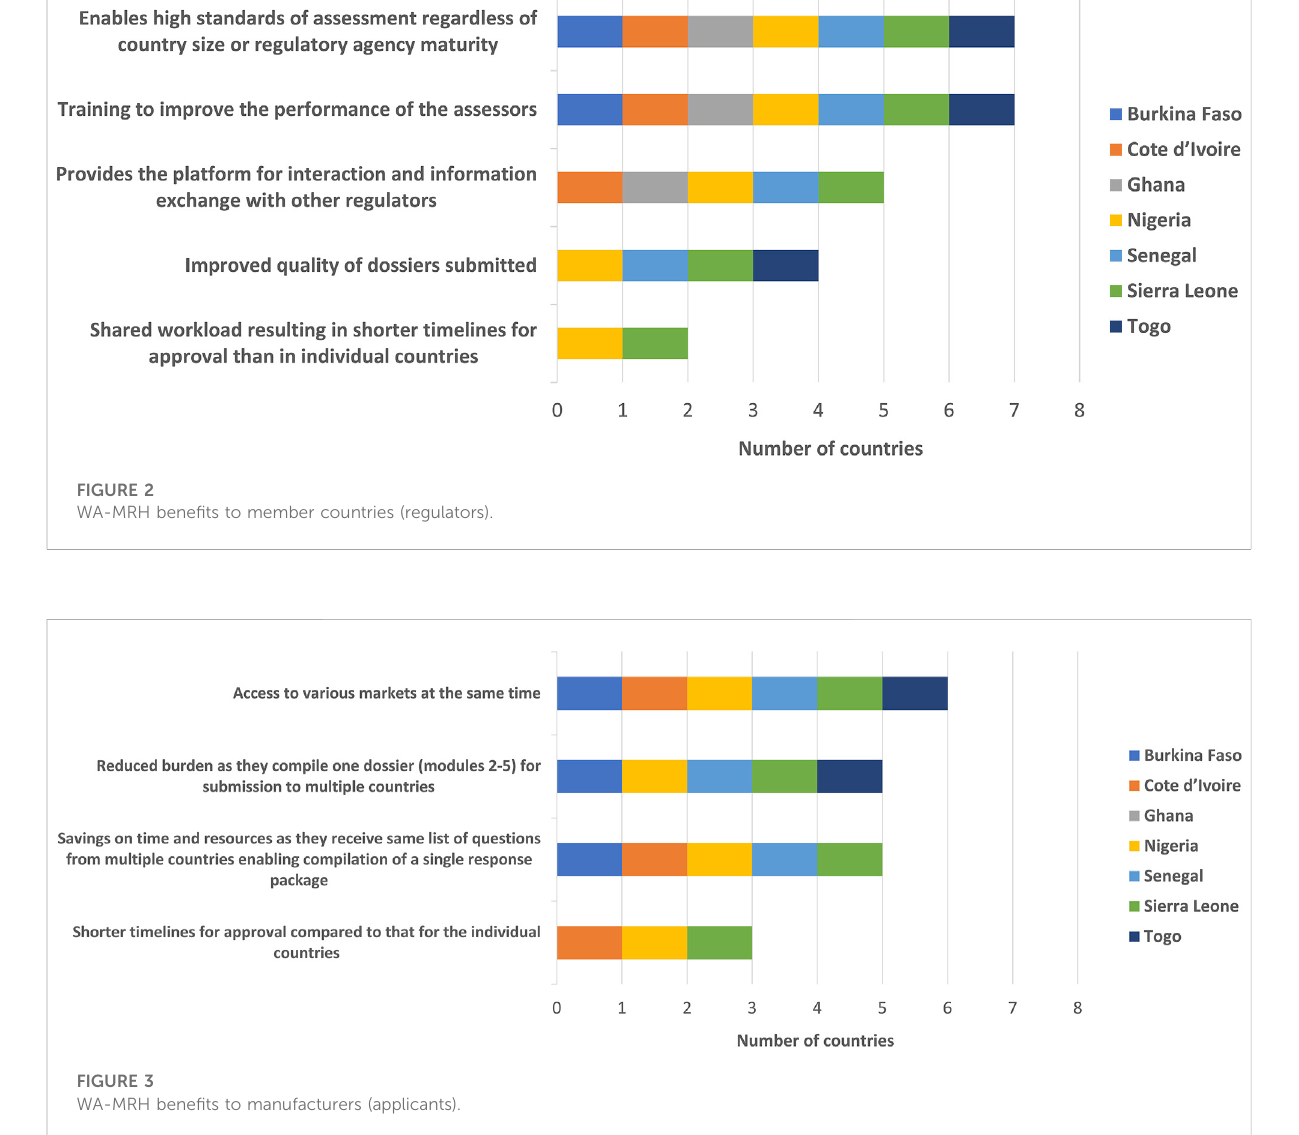
FIGURE 3 WA-MRH bene fi ts to manufacturers